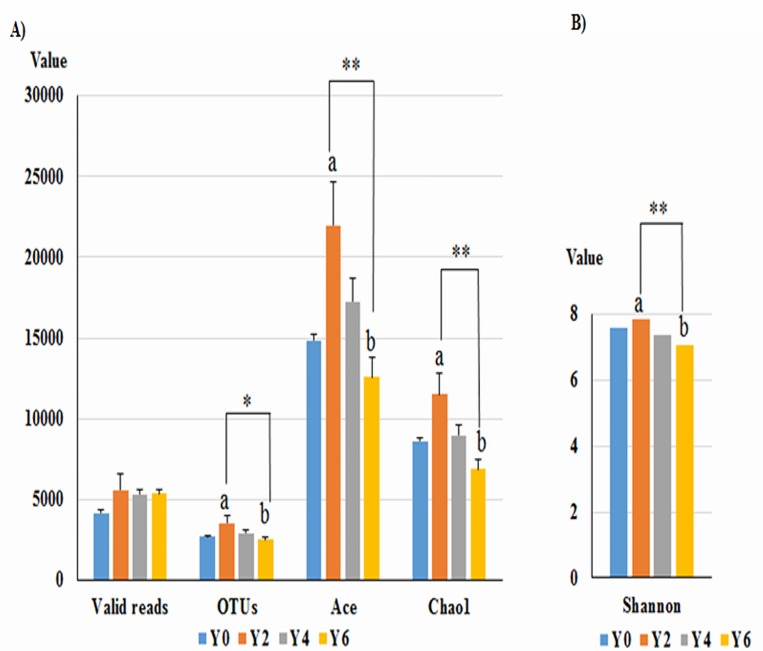
Richness and diversity indices along a time gradient.(A) Richness indices and (B) Shannon’s diversity index. 2-year-old (Y2, n = 6), 4-year-old (Y4, n = 12), 6-year-old (Y6, n = 9), and non-cultivated (Y0, n = 3) soil samples. All values are indicated as the mean ± SE. “a” and “b” indicate differences in alpha diversity indices values between 2-year-old and 6-year-old samples (one-way ANOVA by post hoc Tukey’s test). *, p<0.05; **, p<0.01.